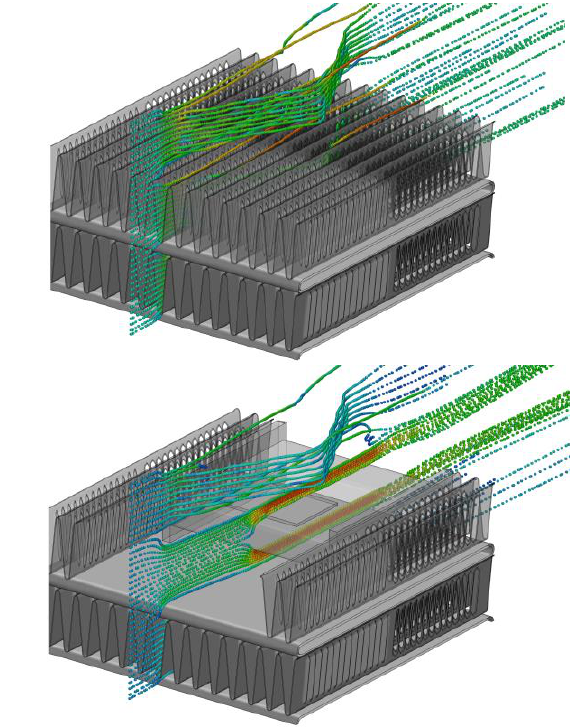
Fig. 5. Flow lines coloured by velocity: segment without sensor at the top, with sensor at the bottom.